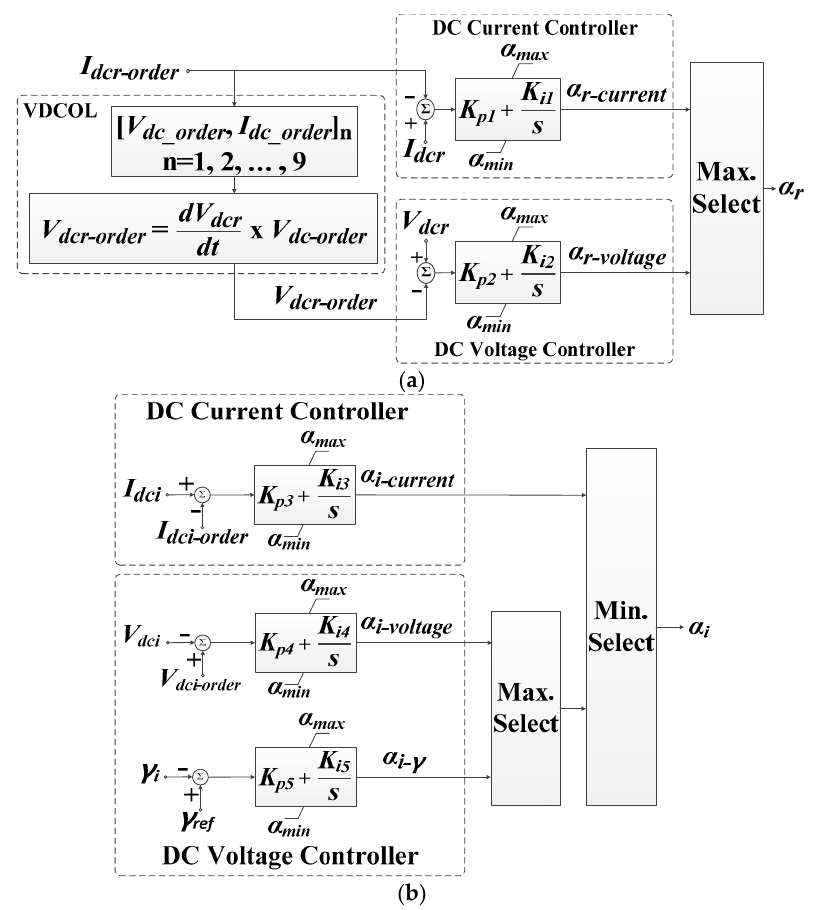
Figure 7. Schematic diagrams of the controller selection module at ( a ) the rectifier and ( b ) the inverter.